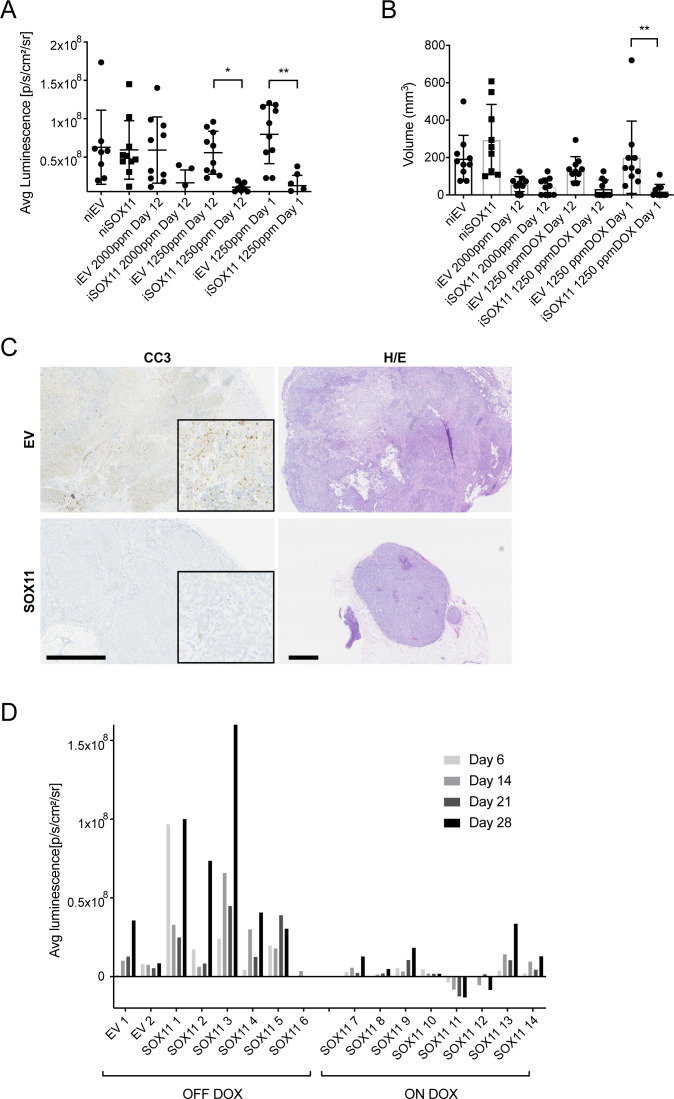
DCIS cells expressing SOX11 form smaller tumours comprised of more viable cells.(A) Average luminescence results in IVIS images after mammary fat pad xenografts of iEV or iSOX11 in mice that were fed with high doses of DOX. (B) Tumour volumes after mammary fat pad xenografts. (C) Representative images of IHC to detect Cleaved Caspase three in tumours resected from mice injected with iEV and iSOX11 tumours. Scale bar: 500 μm. (D) Average luminescence results in IVIS images of mice xenografted with iEV and iSOX11 cells at day 6, 14, 21 and 28 after placing half on DOX or off DOX diet after an initial 42 days on DOX. DOX: Doxycycline.